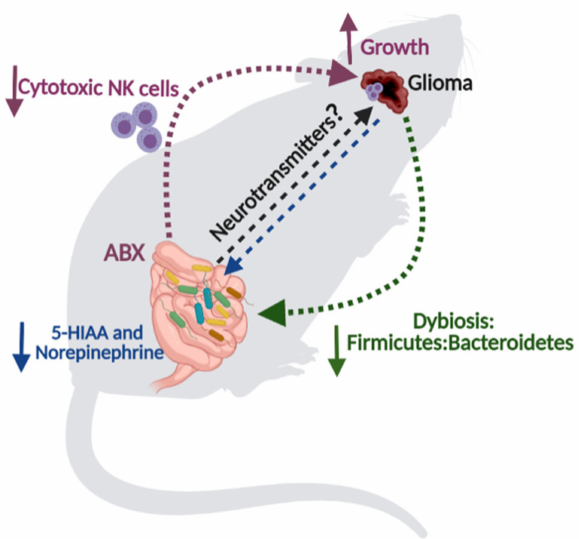
Figure 2. Gut microbiota-glioma crosstalk. Oral antibiotics (ABX)-treated mice show a reduced frequency and cytotoxicity of Natural Killer (NK) cells at systemic and brain tumor level, and an increased glioma growth (purple dotted arrow). Glioma-bearing mice show gut microbiota dysbiosis with a reduced ratio of Firmicutes and Bateroidetes (green dotted arrow), and a decreased fecal level of norepinephrine and serotonin metabolite, 5-hydroxyindoleacetic acid (5-HIAA) (blue dotted arrow). Perspective for gliomas: could brain neurotransmitter levels, modulated by gut microbiota, represent a key determinant for tumor progression? (black dotted